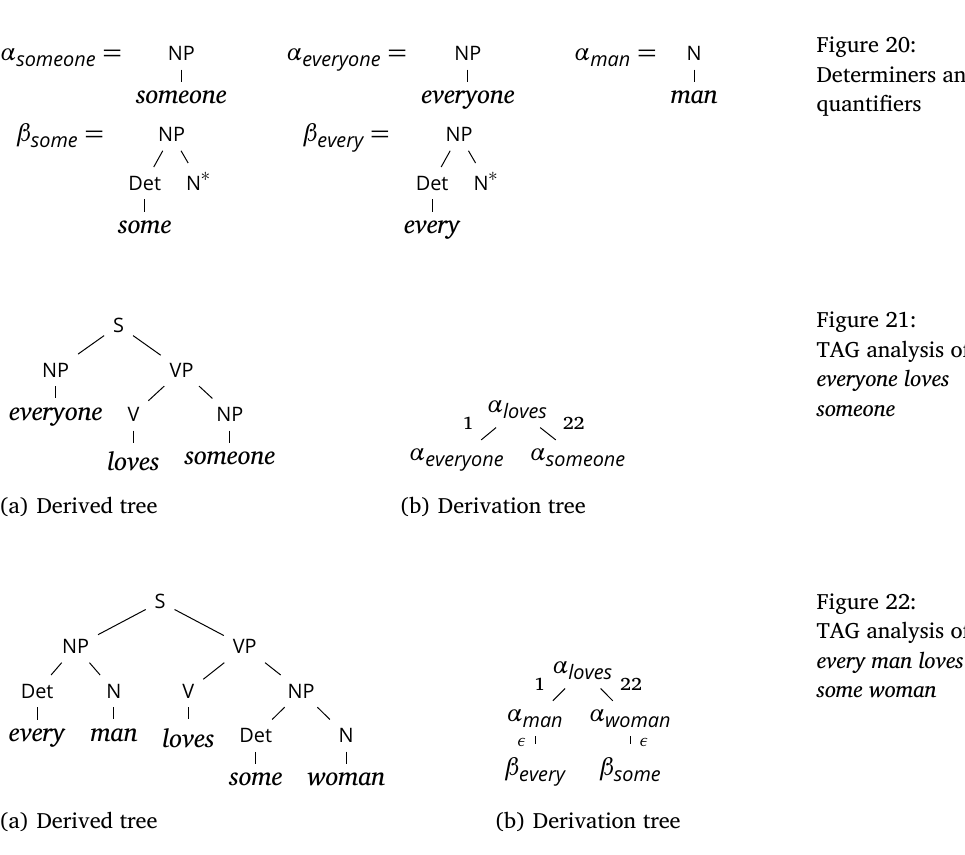
TAG analysis of every man loves some